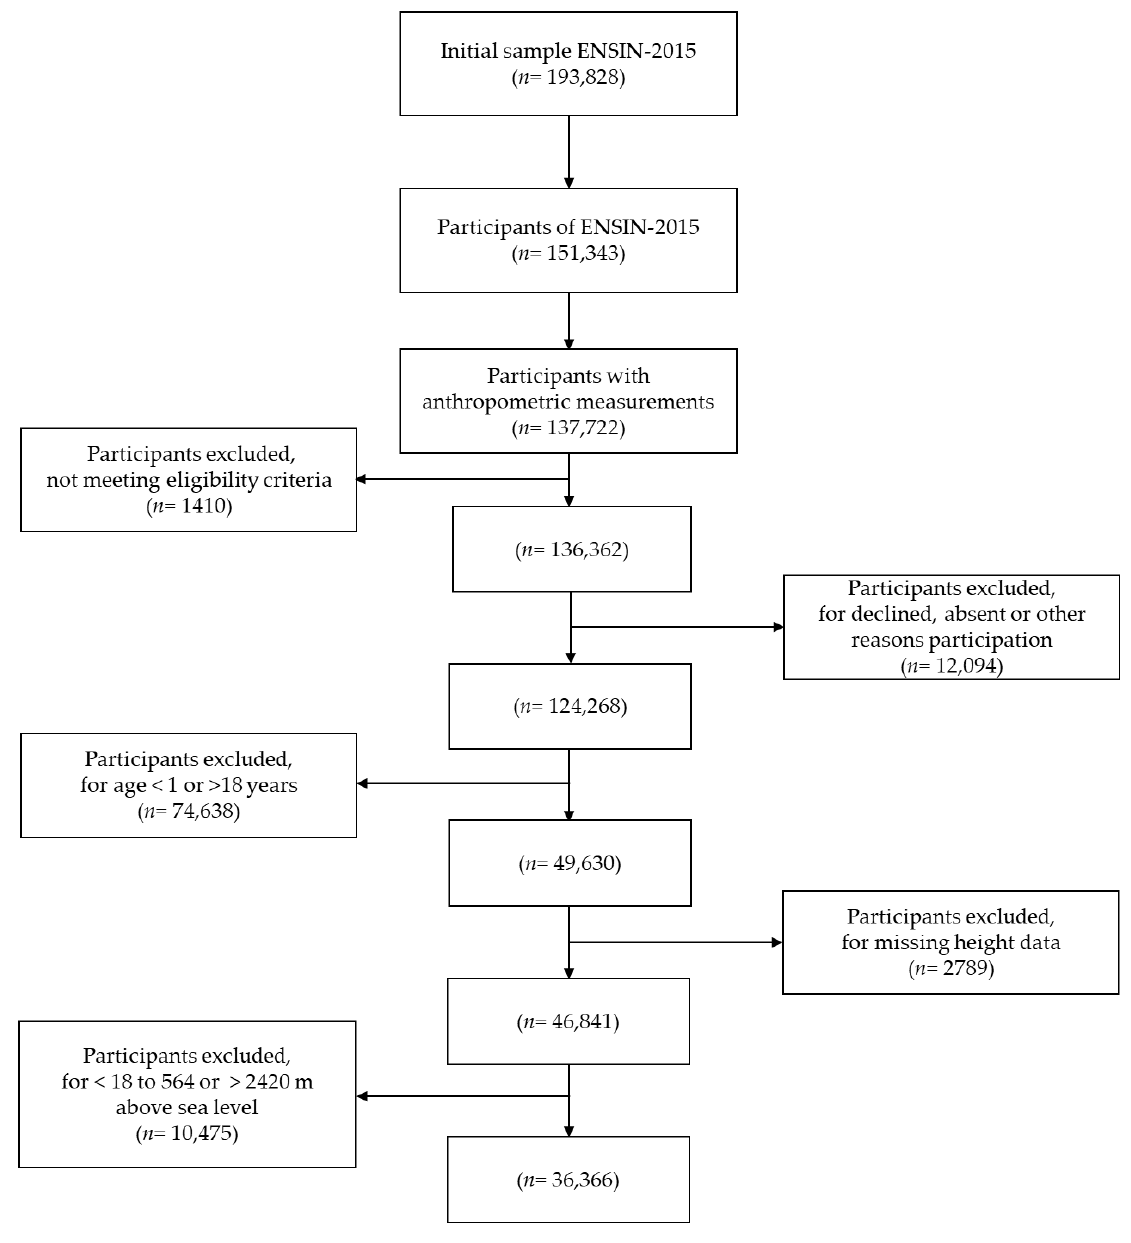
Figure 1. Flowchart depicting final study-subject selection from the ENSIN-2015